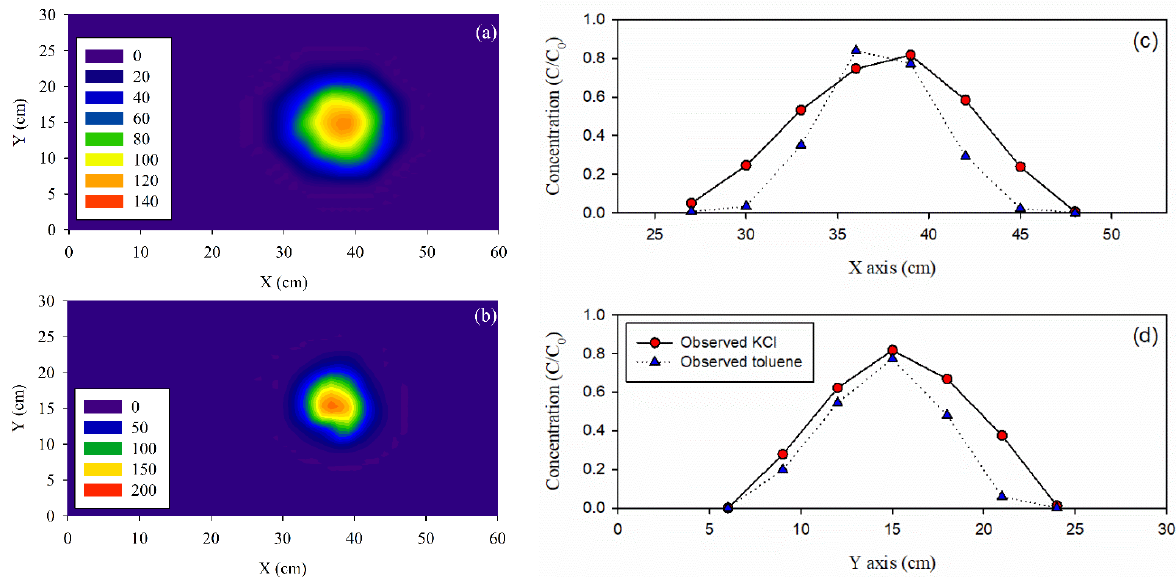
Figure 2. Observed ( a ) KCl and ( b ) toluene plumes at 24 h (unit of contour mg/L). Concentration distribution of toluene and KCl plume: ( c ) longitudinal direction (at y = 15 cm) and ( d ) transverse direction (at x = 39 cm).